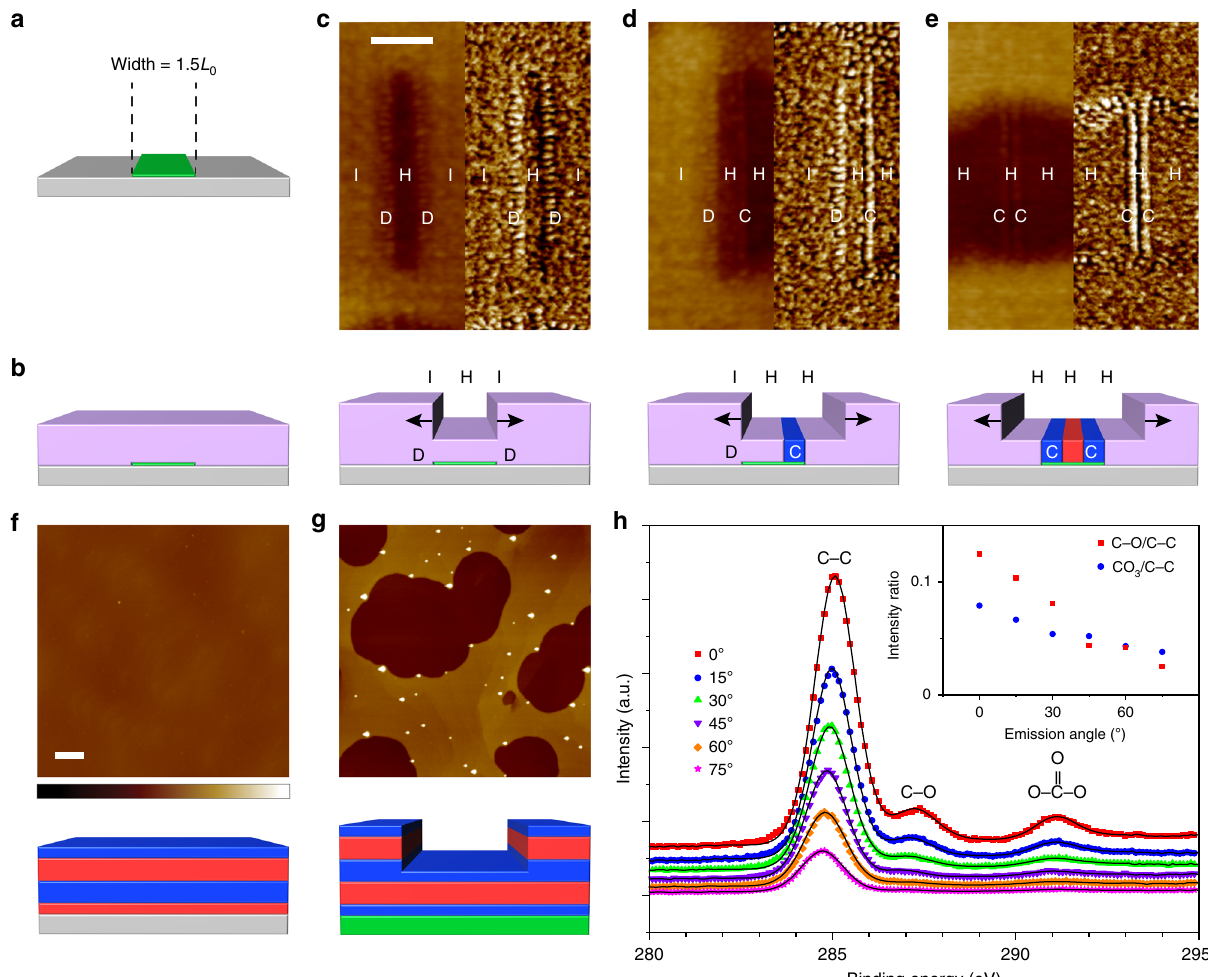
Fig. 4 Effect of hole and island formation. Schematic diagrams ( a – e ) and AFM height (left) and corresponding phase (right) images ( c – e ) of PPC-b-PS-b- PPC ( L 0 of 12.8 nm) morphological evolution during assembly. Holes (H) and islands (I) within the BCP fi lm topography as well as discontinuous domains on the substrate (D) and continuous vertical lamellae on the stripe (C) at the stripe/substrate boundary are indicated. Scale bar for c – e (shown in c ) is 100 nm. Graphene, Ge, vertical PS lamellae, vertical PPC lamellae, and horizontal lamellae are green, gray, blue, red, and purple, respectively. A detailed description of the morphology of the horizontal lamellae is provided in Fig. 5, below. AFM topographic maps of PPC-b-PS-b-PPC ( L 0 of 12.8 nm) with initial thickness of ~1.5 L 0 after assembly on a bare Ge surface ( f ) and on a continuous graphene fi lm ( g ). Schematic diagrams show the corresponding side-view of the BCP fi lm morphology. Scale bar for f , g (shown in f ) is 1 μ m and height scale is 60 nm. Graphene, Ge, PS, and PPC are green, gray, blue, and red, respectively. h Angle-resolved XPS of the C1s spectrum of the fi lm in f collected at emission angles of 0, 15, 30, 45, 60, and 75° (top spectrum to bottom spectrum). Inset plots the integrated intensity ratio of the C ─ O peak (red squares) and CO 3 peak (blue circles) to the C ─ C peak versus emission angle. See Supplementary Figs. 2 – 8 and Supplementary Note 1 for additional detail. The graphene stripe thickness is exaggerated so that the stripes can be visualized more BCP from stripe to substrate. The fi lm thickness increases gradually between the holes and islands. In the sloped regions, the horizontal lamellae on the substrate curve upward and contact the free surface at the top of the BCP fi lm (Fig. 5d, e). Similar slanted lamellae have been observed at step edges in di-BCP fi lms 53 . The slanted lamellae act as a template to convert the lamellar domains on the stripes from horizontal to vertical. Speci fi cally, the bottommost A lamella on the substrate curves upward to form a through- fi lm domain directly bordering the stripe edge.